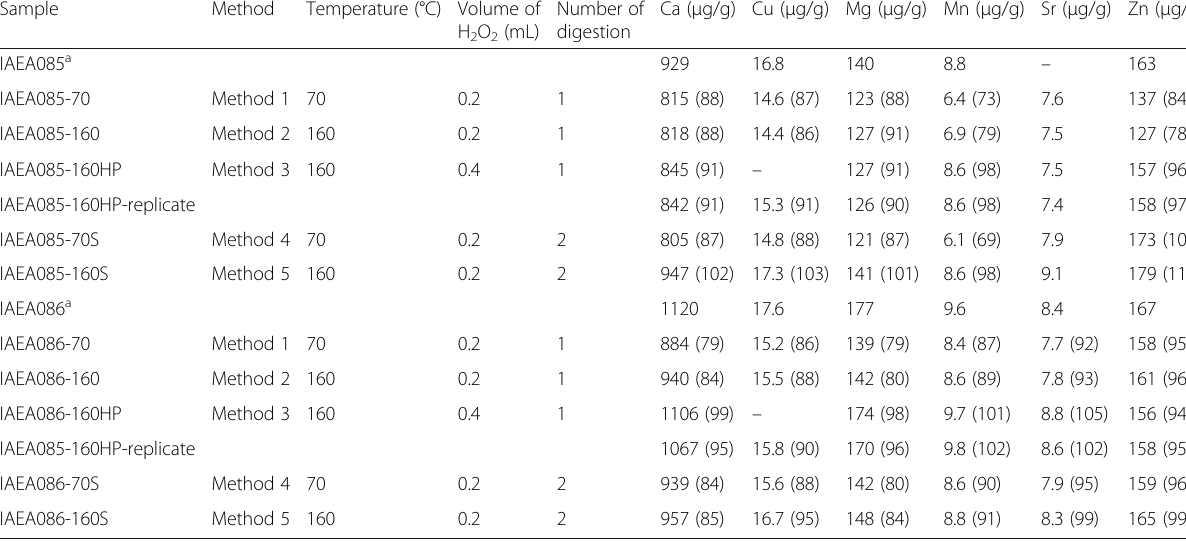
Table 1 Trace elements in two certified reference human hairs (IAEA085 and IAEA086) Sample